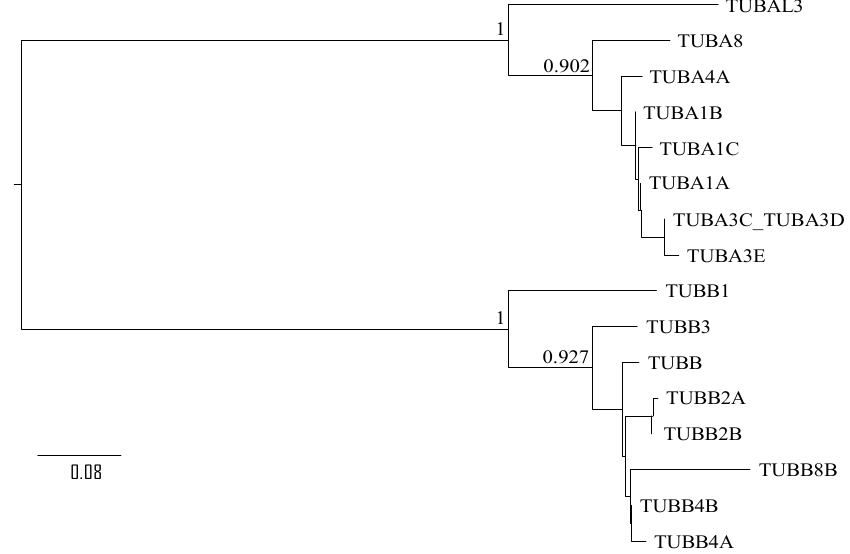
Figure 3. Phylogenetic tree from PhyML (LG substitution model and TLR option for simultaneous optimization of topology, branch length, and rates) based on aligned amino acid sequences of tubulin proteins. The tree was mid-point rooted.